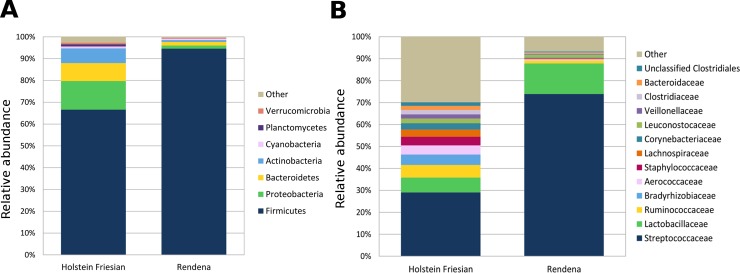
Distribution of the sequence relative abundances summarized at phylum (A) and family (B) levels. Relative proportions of bacterial taxonomic groups that were present in at least 1% relative abundance in quarter milk samples at a rarefaction depth of 35,959 sequences. All bacterial taxa present at less than 1% relative abundance were grouped into the “Other” classification.